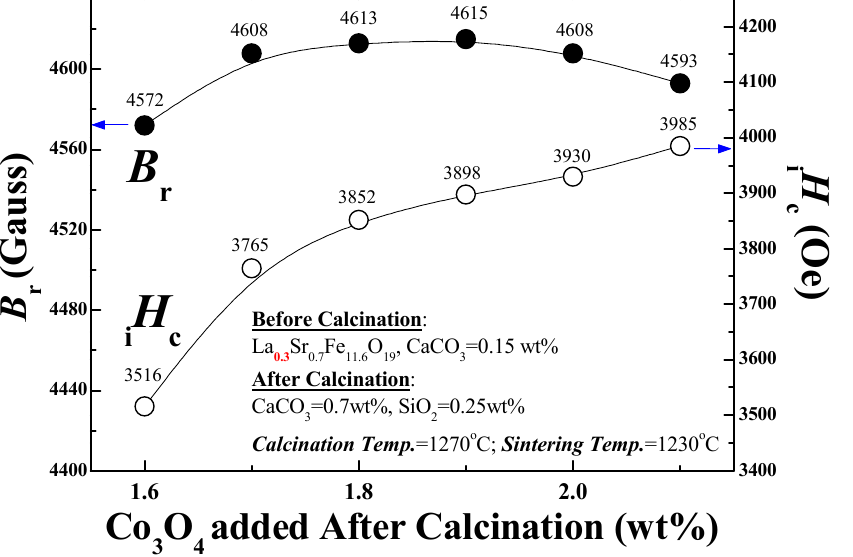
Figure 9. Dependence of B r and i H c of the sintered magnet on the amount of Co 3 O 4 added after the calcination process.